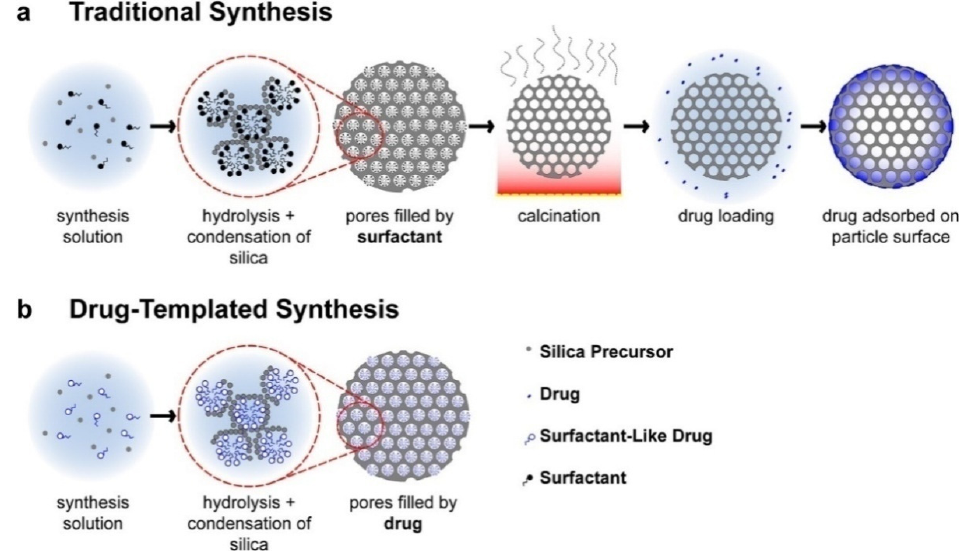
Figure 14. Traditional concentration-gradient-driven drug loading ( a ) and drug-templated synthesis of MSNs ( b ). Reprinted with permission from